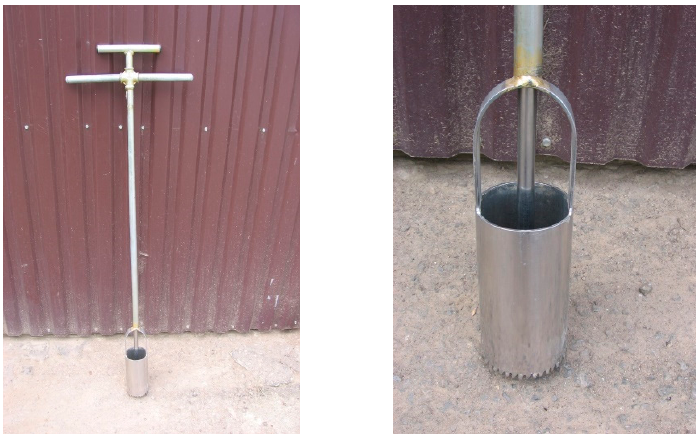
Figure 1. Soil sampling tube.